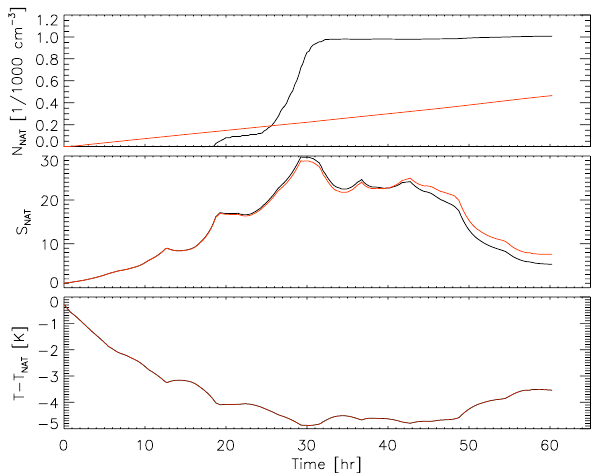
Fig. 5. A comparison of the volume-based nucleation rate parame- terisation (red) and the new parameterisation (black). Both versions of the model were run along the temperature trajectory shown in the bottom panel. The development over time, of NAT number density and saturation with respect to NAT, is shown in the top and middle panels